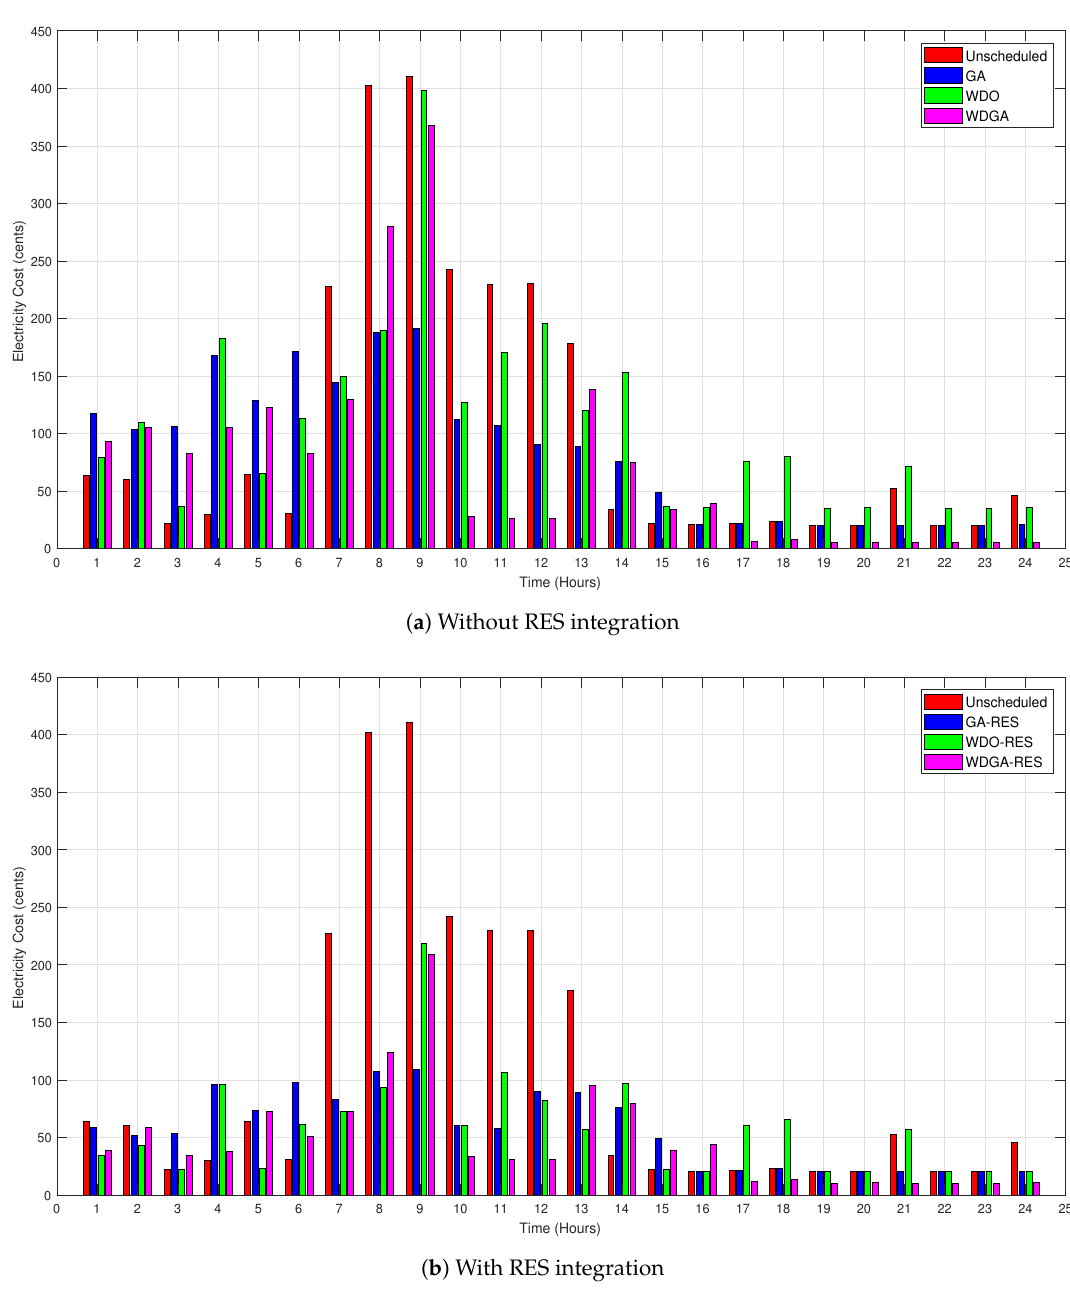
Figure 7. Electricity cost of